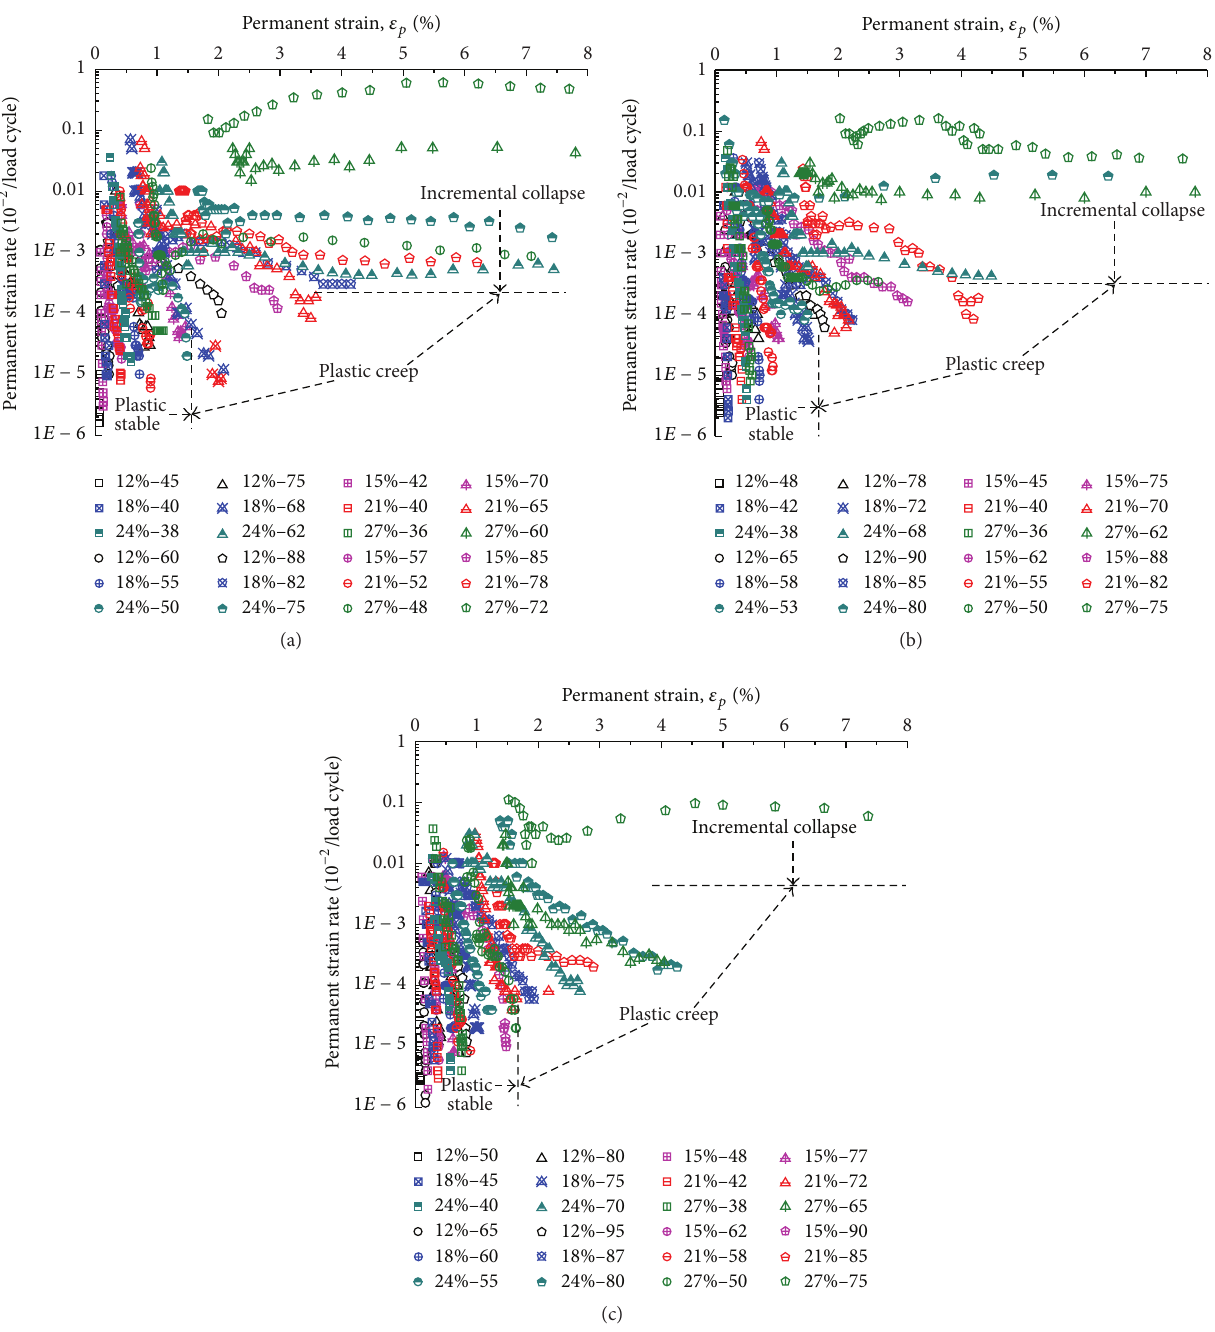
Figure 7: Relationship between permanent strain rate (log scale) and permanent strain under combination of various moisture contents and deviator stress values for different degrees of compaction: (a) 𝑘 = 90 %; (b) 𝑘 = 93 %; (c) 𝑘 = 96